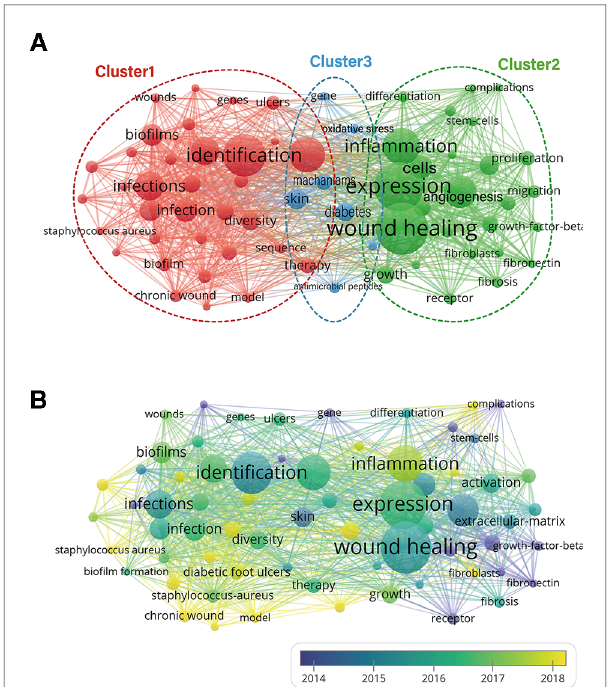
FIGURE 7 Mapping of co-occurrence analysis of HTS technology associated with chronic wounds. ( A ) Mapping of the 149 identi fi ed keywords. The frequency is represented by point size, and the keywords of research fi elds are divided into three clusters: microbial infection of chronic wounds (red), healing process of wounds and microscopic processes (green), skin repair mechanism stimulated by antimicrobial peptides and oxidative stress (blue). ( B ) Distribution of 149 identi fi ed keywords according to frequency and average time of occurrence; keywords in yellow appeared later than those in